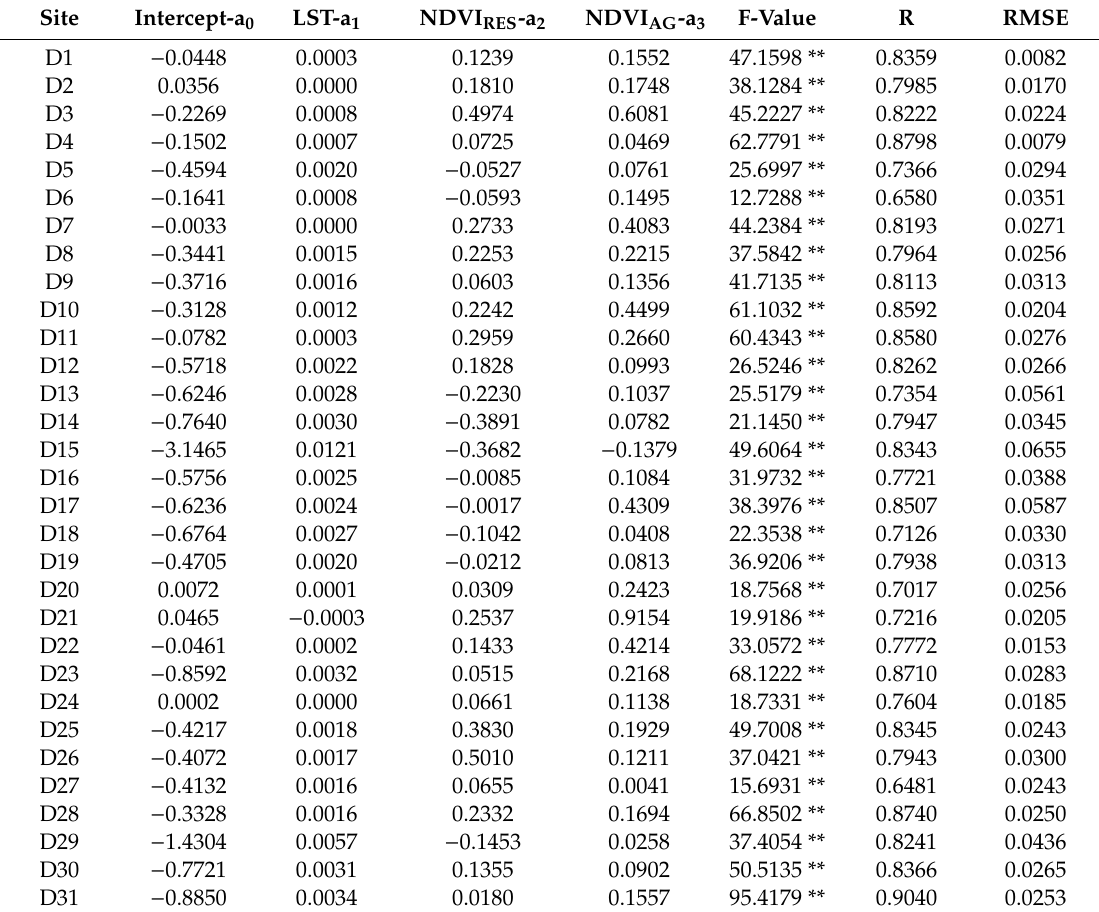
Table A1. Layer soil moisture estimation model (10–20